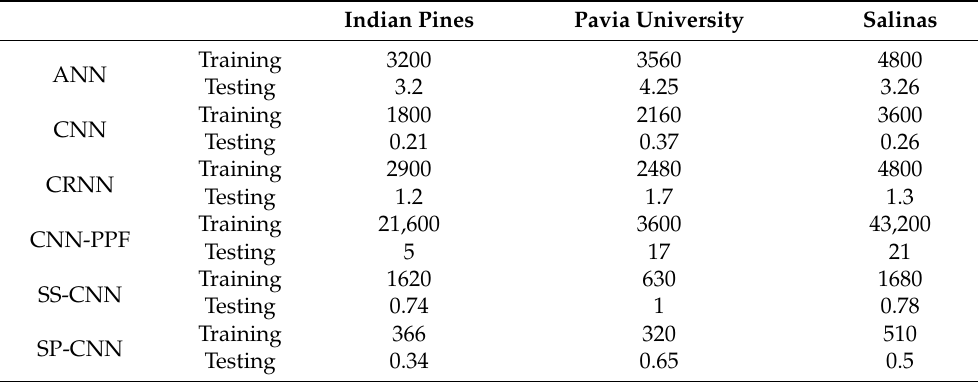
Table 5. Running time (seconds) of six classification schemes on three datasets with no more than 30 labeled pixels per